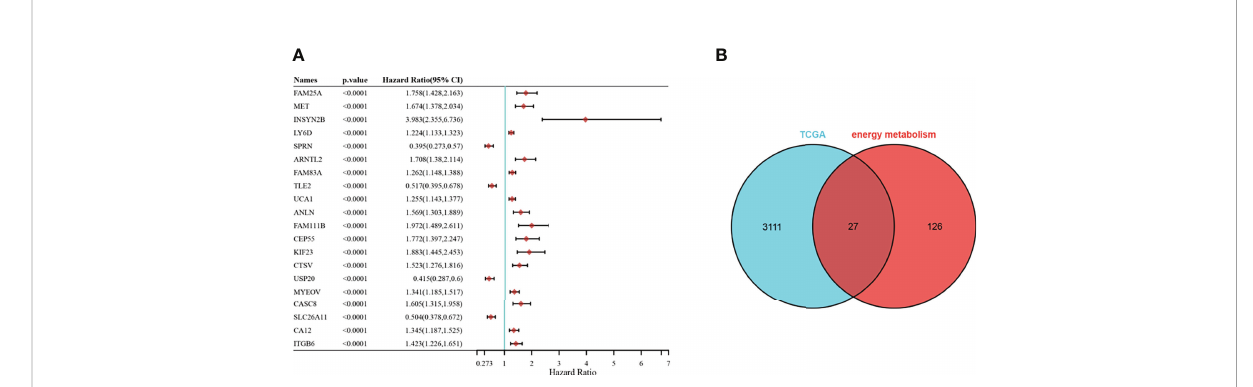
FIGURE 2 Selection of prognosis-related energy metabolism genes. (A) : Forest plot of the top 20 signi fi cant prognostic genes; (B) : Venn plot.